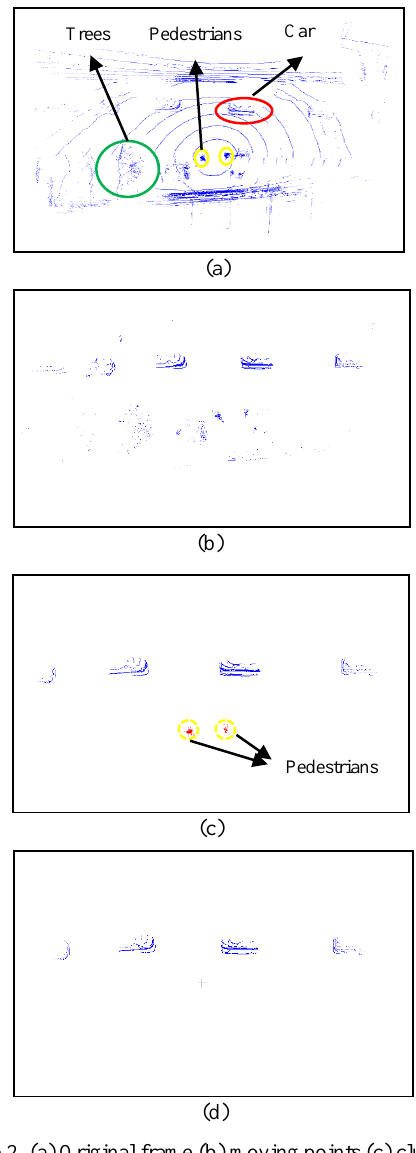
Figure 2. (a) Original frame (b) moving points (c) clustering results (d) classification